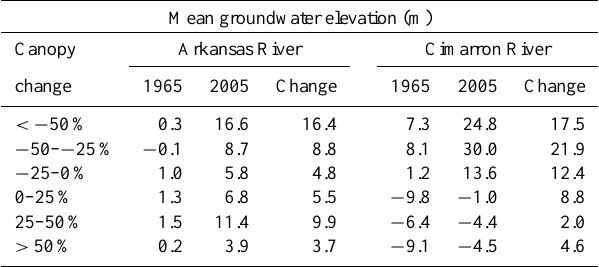
Table 4. The mean pre- and post-development groundwater eleva- tion and the change in groundwater elevation are tabulated for each class of % change in canopy area. Negative values indicate higher groundwater than river elevation, and that baseflow conditions exist from groundwater to surface